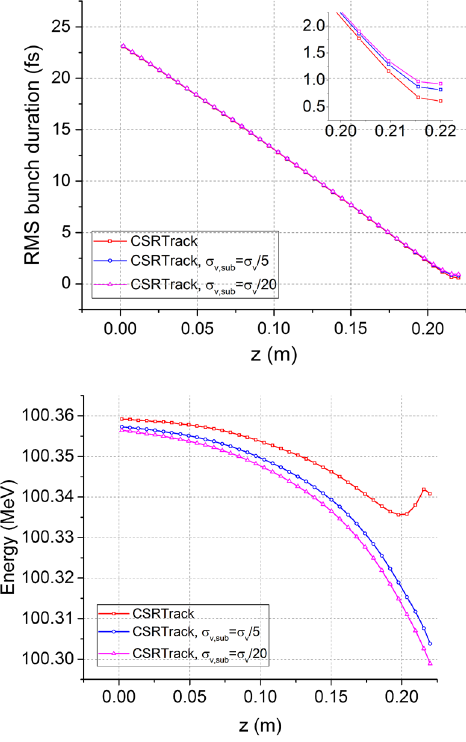
FIG. 6. Evolution of the bunch durations and energies in the last dipole magnet simulated by CSRT rack for different vertical sub-bunch sizes. The bunch charge is 2.7